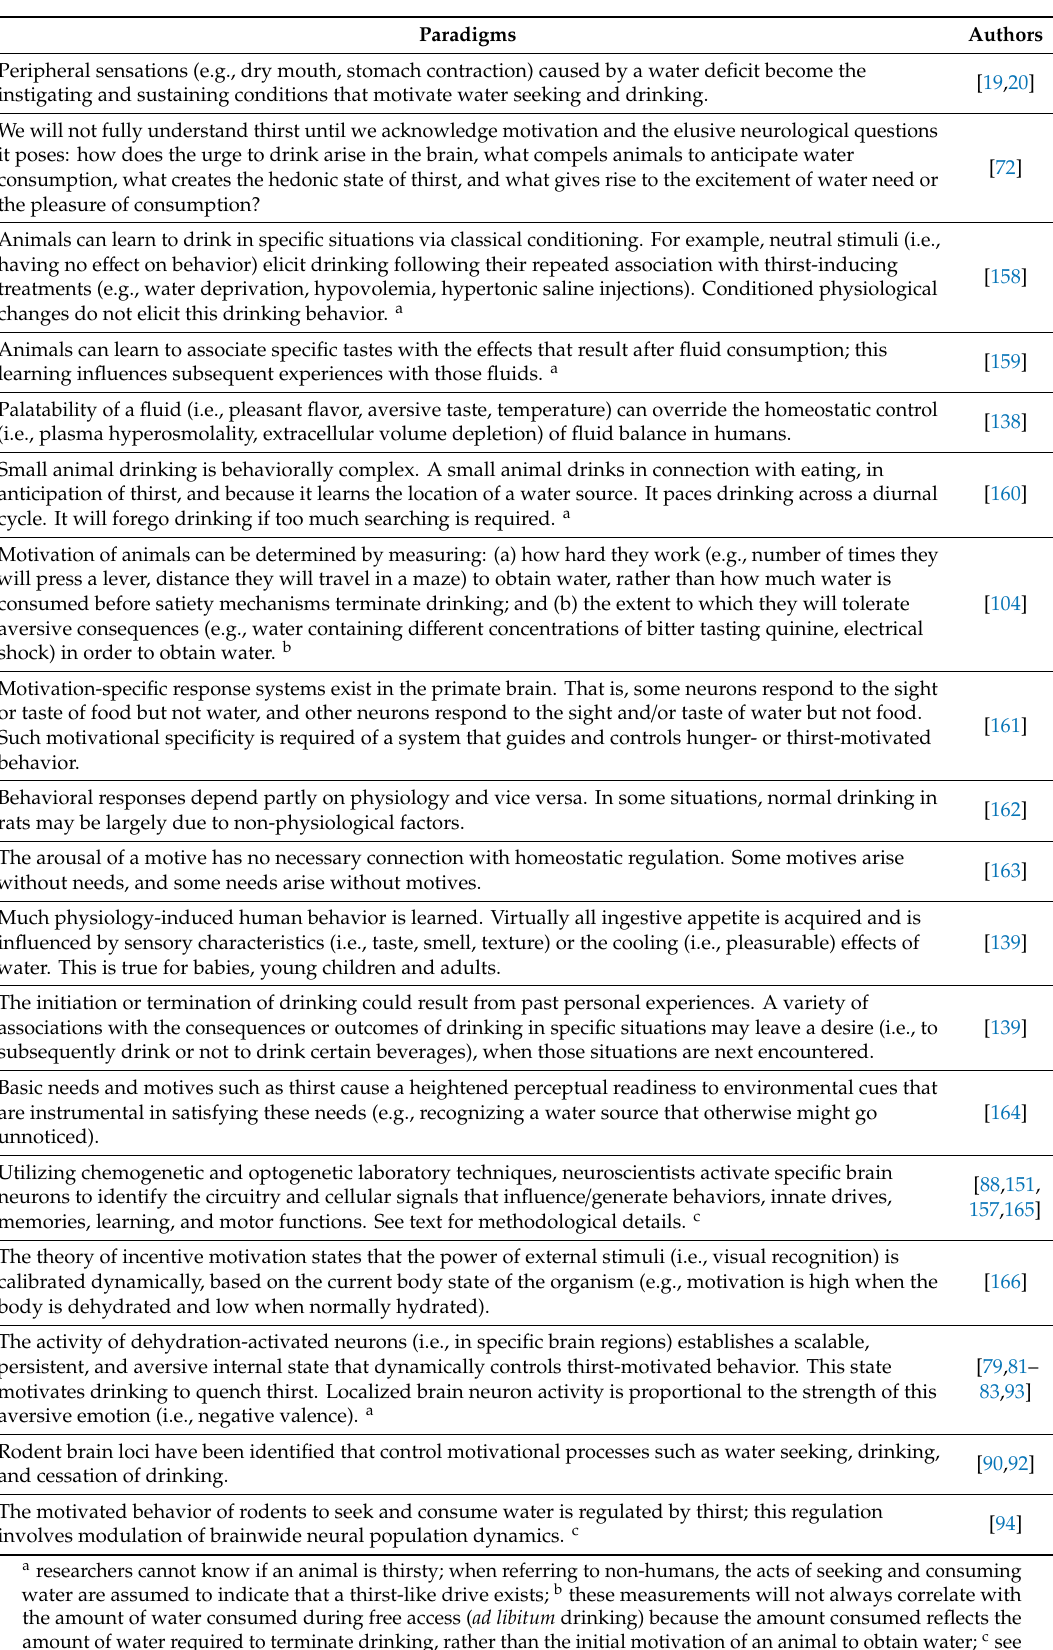
Table 7. The importance of incentive, motivation and learning in thirst and the drinking behavior of rodents, primates, and